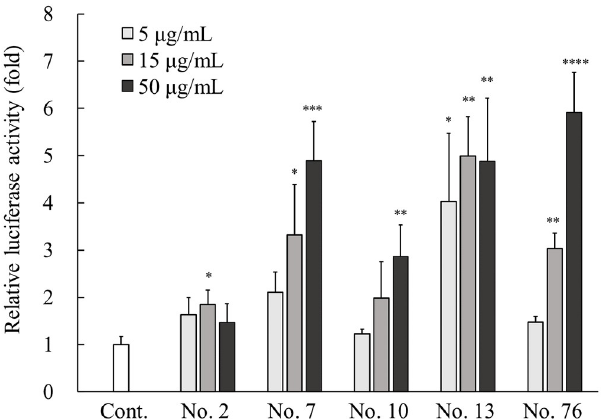
Fig 1. Effects of five positive hits of plant extracts on Sema3A reporter gene expression. NHEKs were transfected with pGL3- Sema3A . After transfection, the cells were incubated with five plant extracts, namely No. 2, 7, 10, 13, and 76 at a final concentration of 5, 15, and 50 μ g/mL for 48 hours at 37˚C. Cell lysates were subjected to luciferase activity measurement as described in Materials and methods. All results are expressed as mean ± SD of three independent experiments. � p < 0.05, �� p < 0.01, ��� p < 0.001, ���� p < 0.0001 (one-way ANOVA followed by Dunnett’s